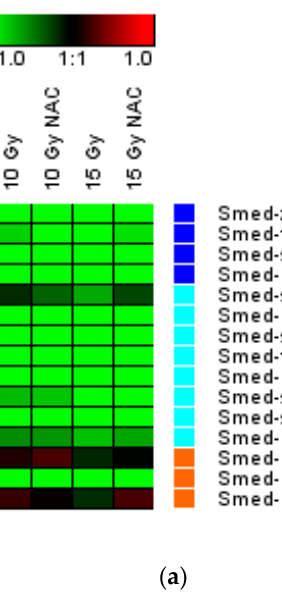
Figure 4. Gene expression of three classes of neoblast markers in regenerating planarians treated with NAC (10 mM) for 3 h ( a ) and 6 h ( b ) after irradiation. The intensity scale of the standardised expression values range from − 3 (green: low expression) to +3 (red: high expression), with a 1:1 intensity value (black) representing the control (unirradiated).